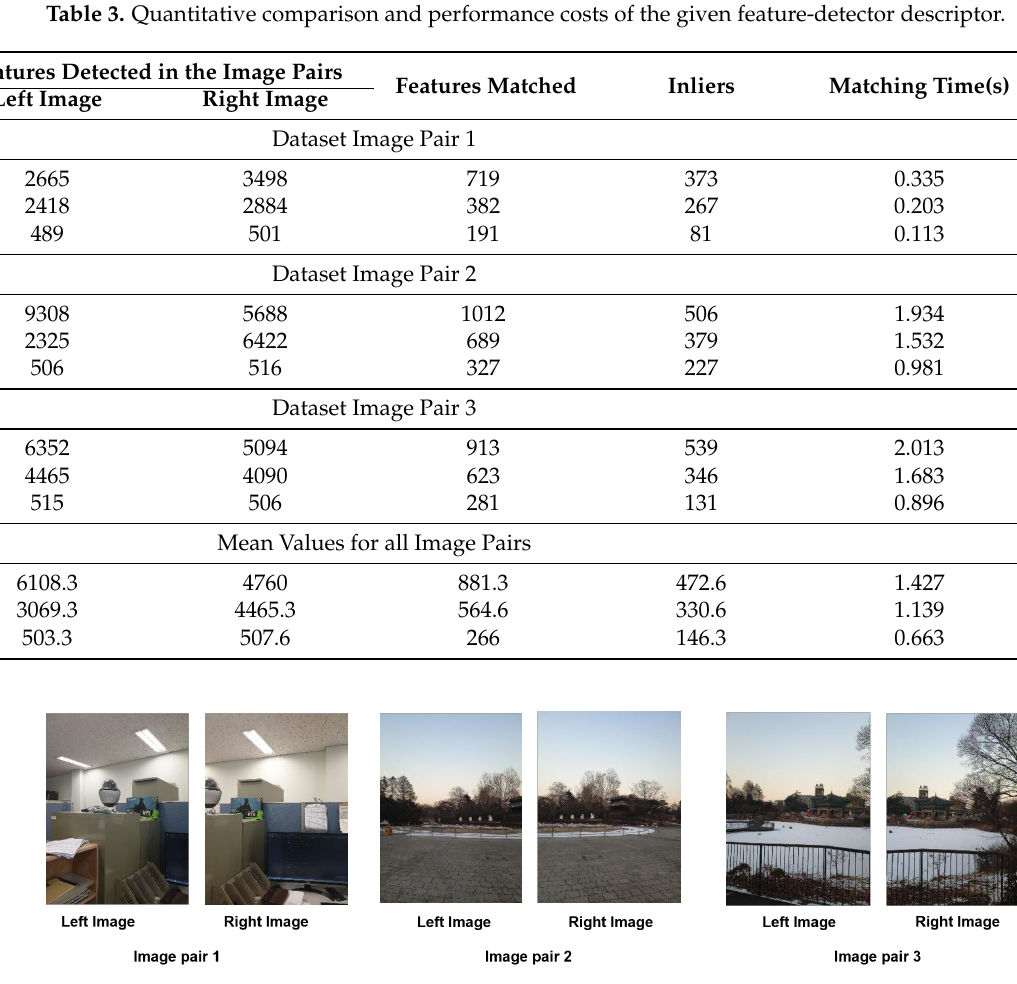
Figure 9. Shows the 3 pairs of images, with each pair containing two images (left image and right image with a sufficient overlap